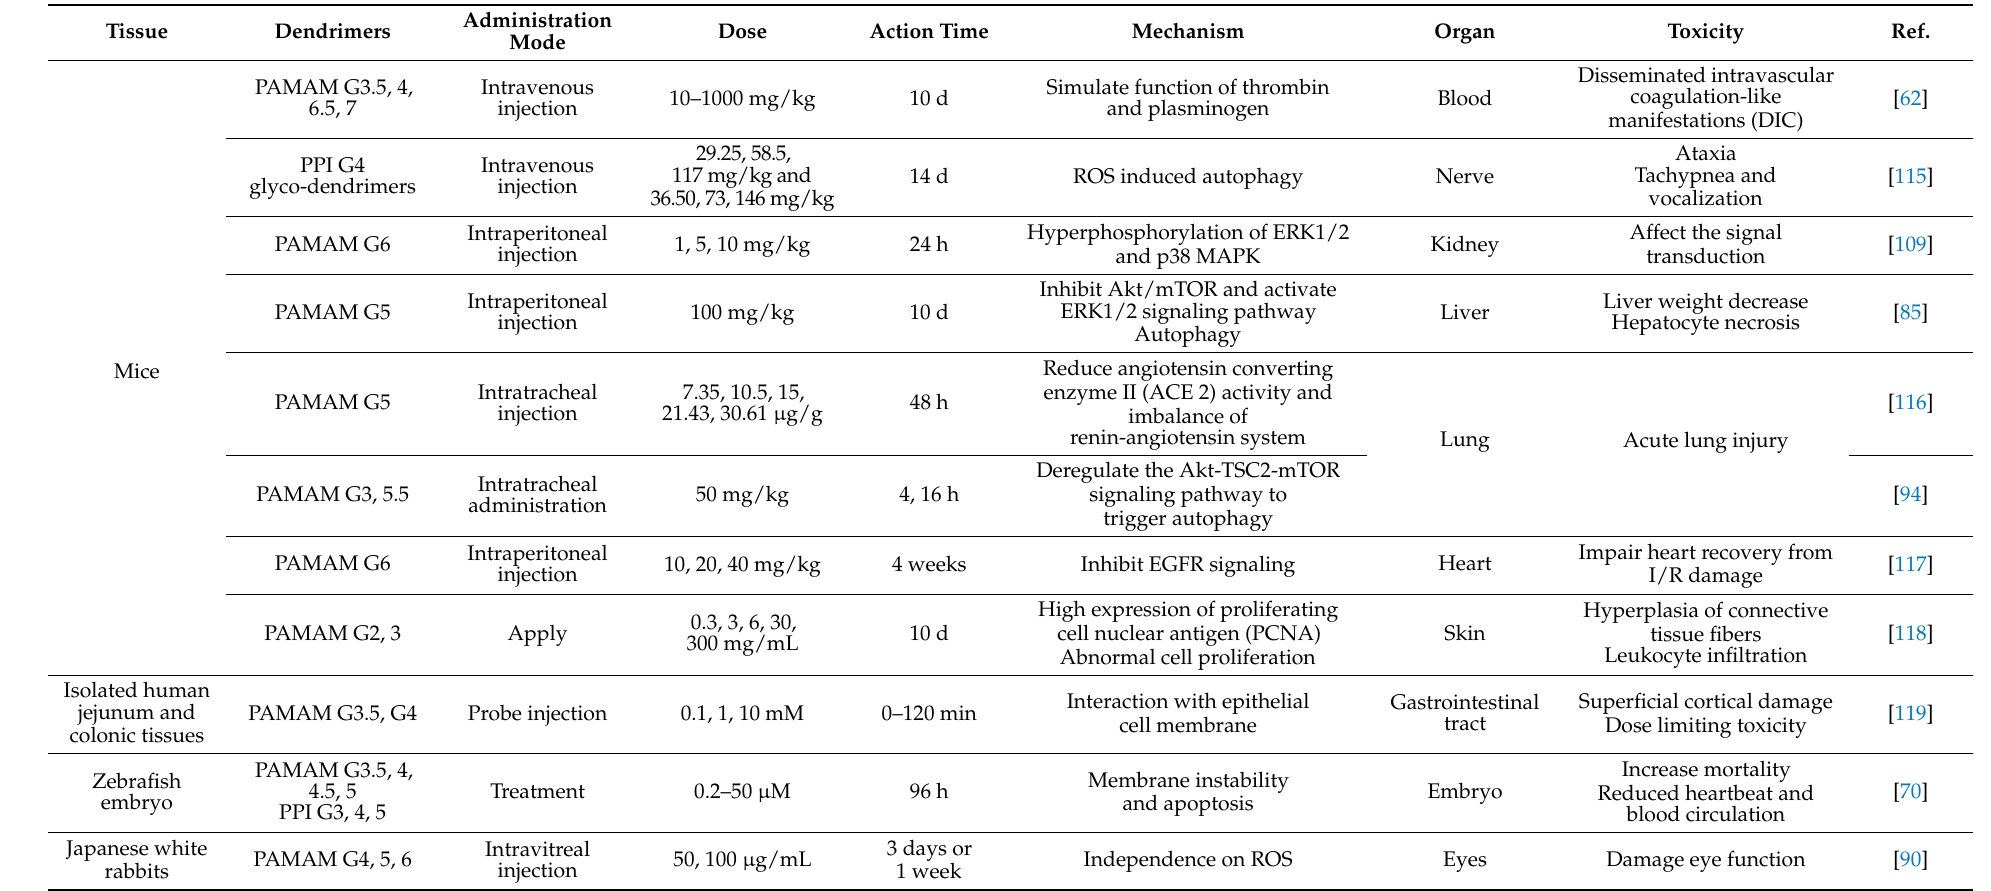
Table 2. Toxicity of dendrimers in different